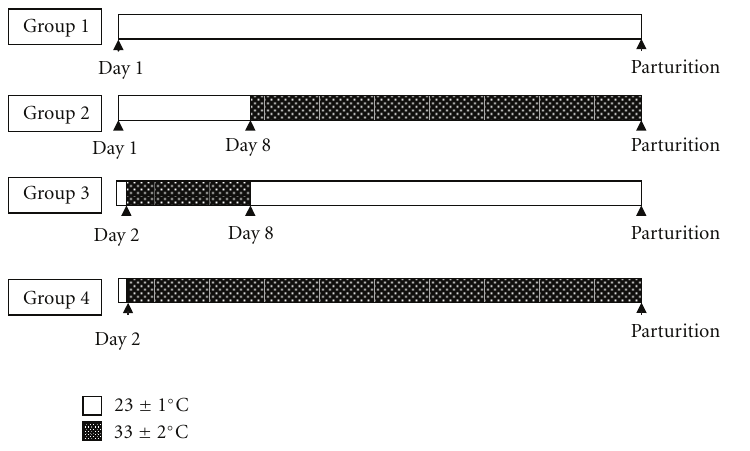
Figure 1: Schematic illustration of pregnancy period and time of exposure to elevated temperatures in the four